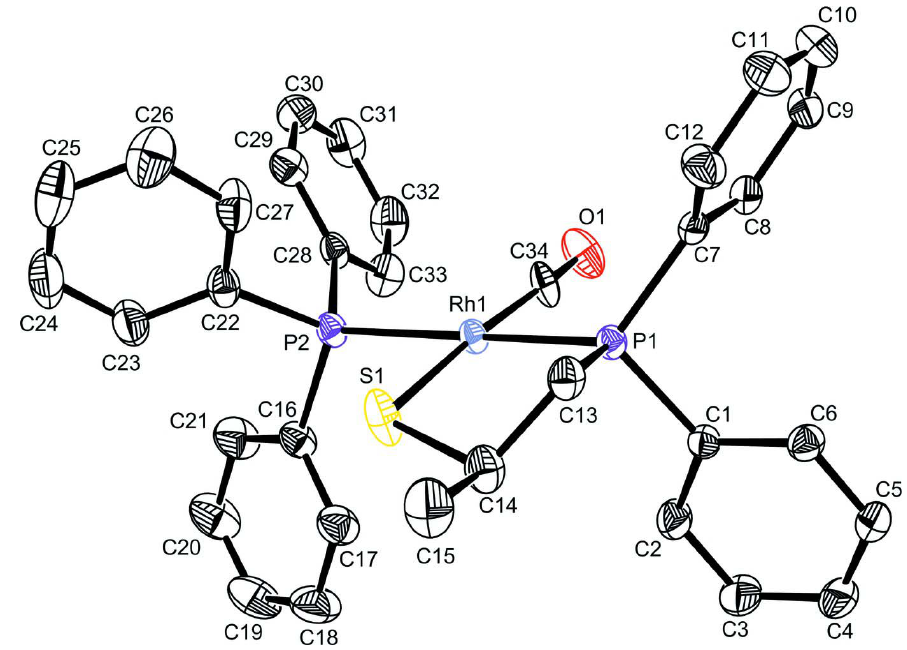
Molecular structure of (I) with the atom-labeling scheme. Displacement ellipsoids are drawn at the 30% probability level. Disordered atom and hydrogen atoms were omitted for